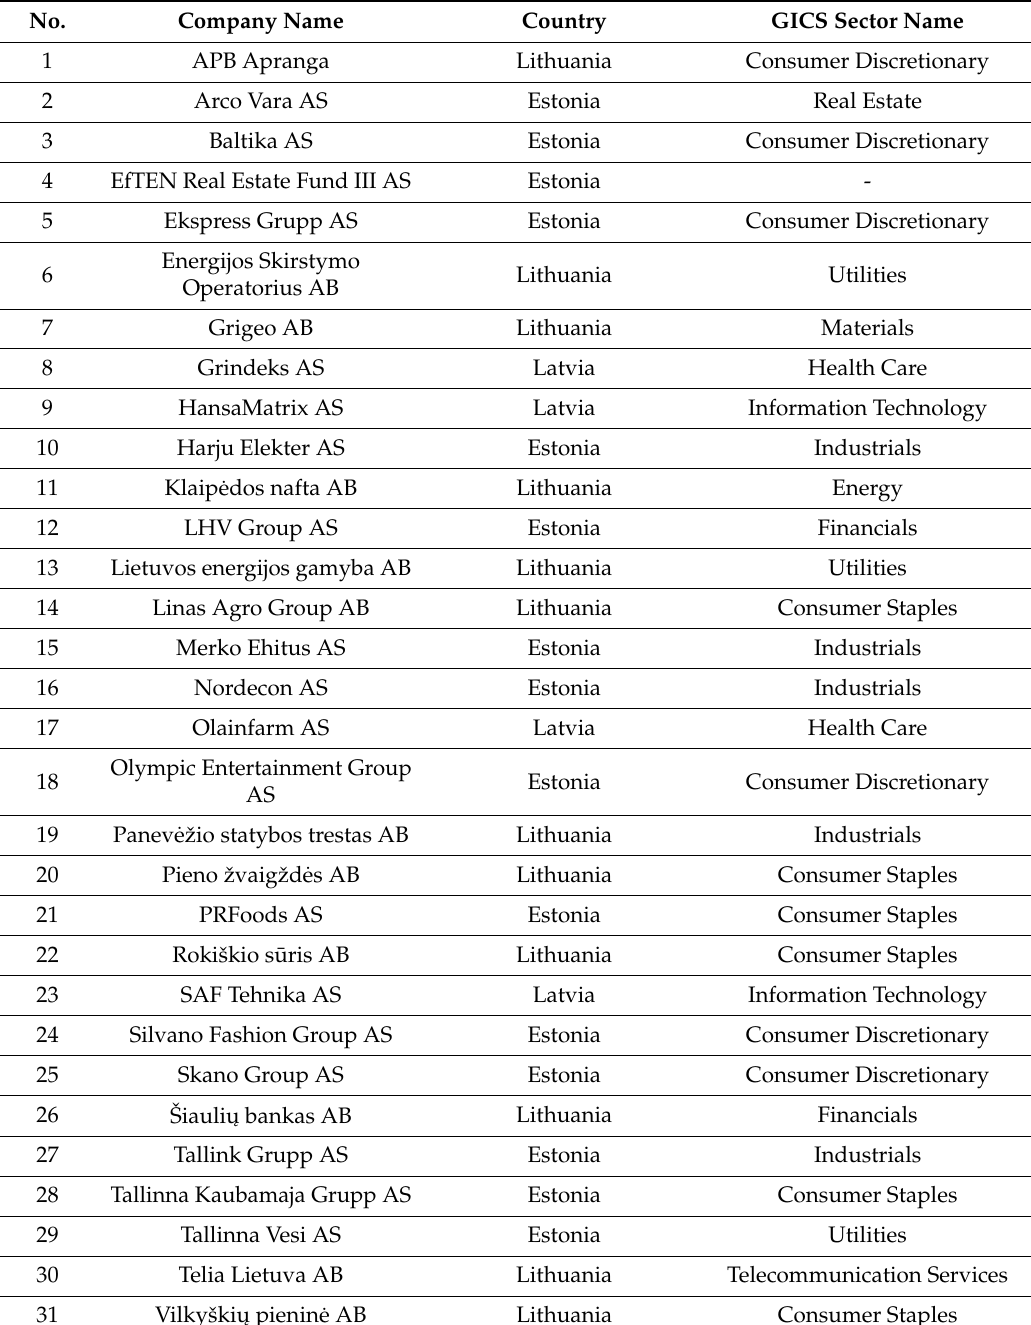
Table A1. Baltic Main List